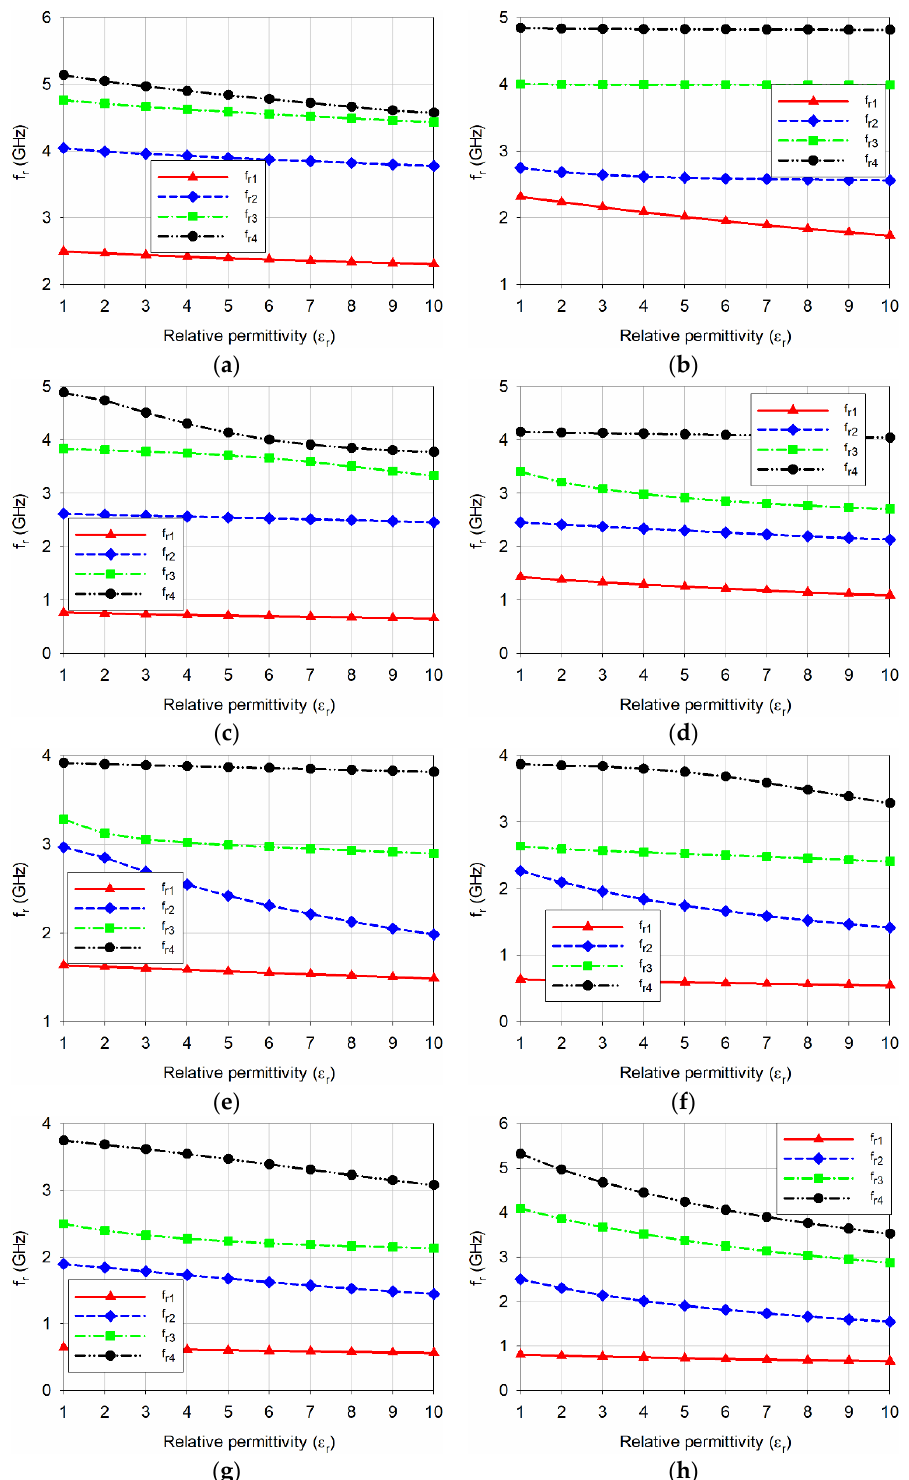
Figure 4. Variations on the first four resonant frequencies when varying the relative permittivity of the MUT from 1 to 10 for: ( a ) the conventional MPSA without DGS; ( b ) the RS DGS-loaded MPSA; ( c ) the SR-CSRR-OS DGS-loaded MPSA; ( d ) the SR-CSRR-IS DGS-loaded MPSA; ( e ) the R-SR-CSRR DGS-loaded MPSA; ( f ) the DR-CSRR-RA DGS-loaded MPSA; ( g ) the DR-CSRR-CA DGS-loaded MPSA; and ( h ) the proposed scaled DR-CSRR DGS-loaded MPSA.